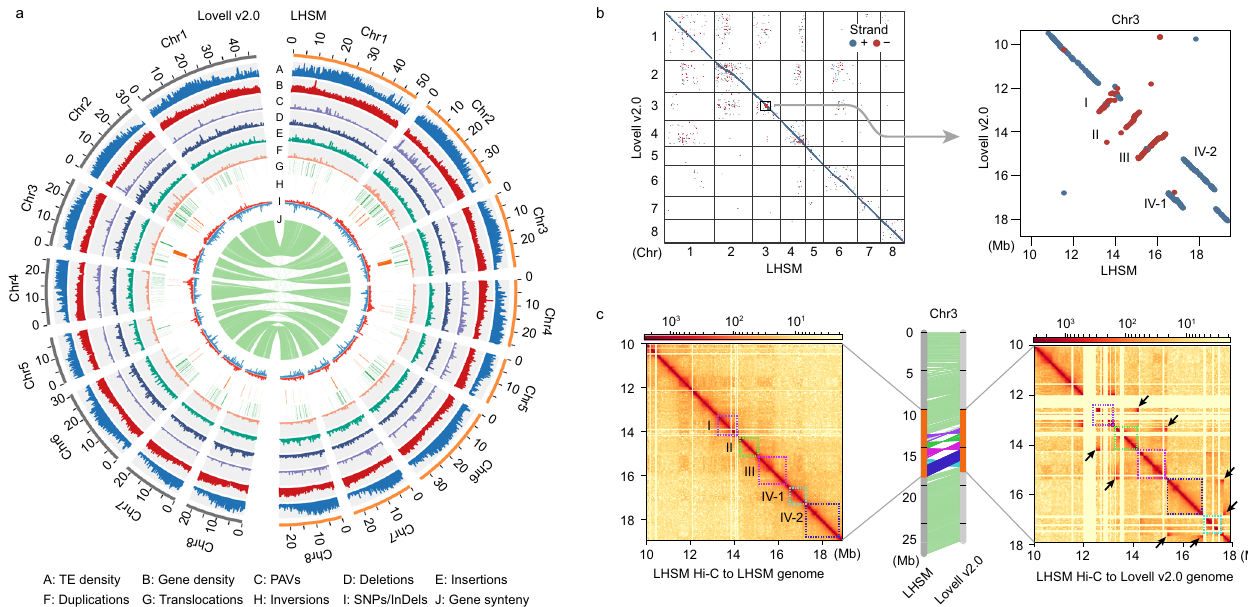
Fig. 1 LHSM genome assembly. a Genomic features and variation landscape across the LHSM and Lovell v2.0 genome assemblies. The outer gray (left) and yellow (right) tracks represent the chromosomes of the LHSM and Lovell v2.0 genome assemblies, respectively, with unit in Mb. b Genomic synteny map and three misorientations (I, II, III) and the adjacent misordering (IV-1 and IV-2) on Chr3 between these two genome assemblies. c Validation of the misorientations and the misordering by aligning Hi-C data of the LHSM genome to the Lovell v2.0 genome. The arrangements of I, II, III, IV-1, and IV-2 regions (highlighted by distinct color lines or boxes) on the LHSM genome are supported by contacts. The color intensity of the Hi-C heatmap represents the number of links between two 40-kb